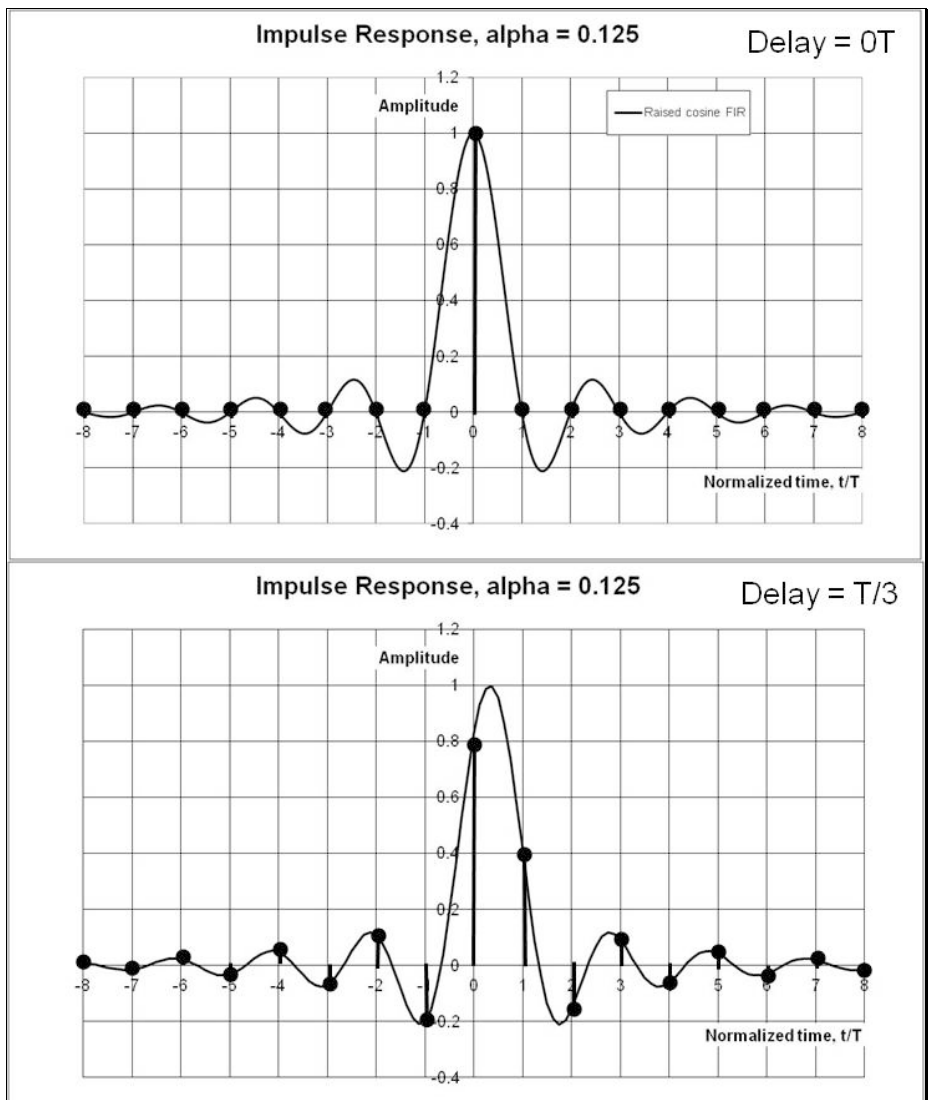
Figure A4. Impulse responses of band-limited integer and fractional delay filters [19].